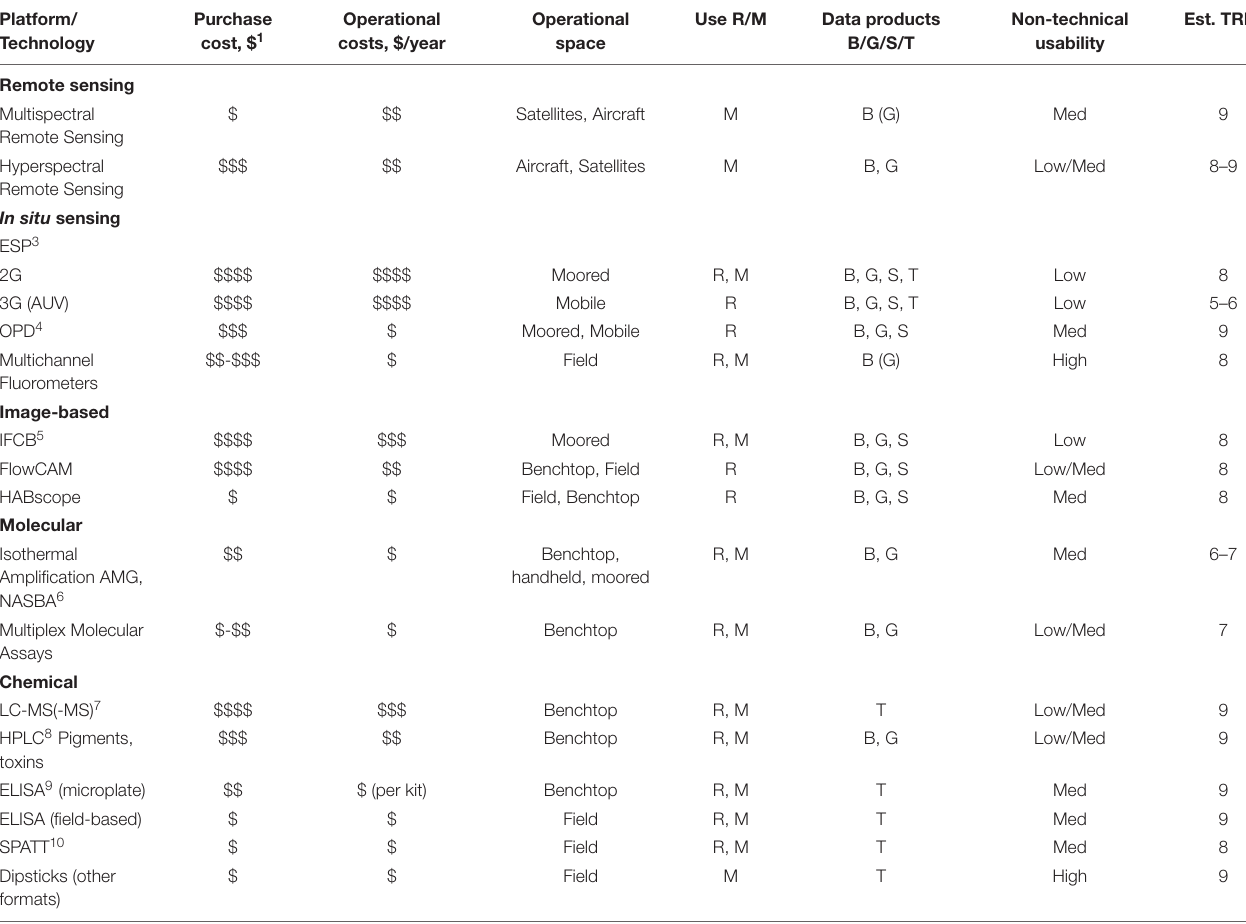
TABLE 1 | Summary of existing technologies currently used to measure HAB biomass, taxa, or toxins, indicating relative purchase and operational costs, operational space (i.e., benchtop versus moored technologies), effectiveness of use for research (R) versus monitoring (M), data products measured (B: biomass, G: genus, S: species, T: